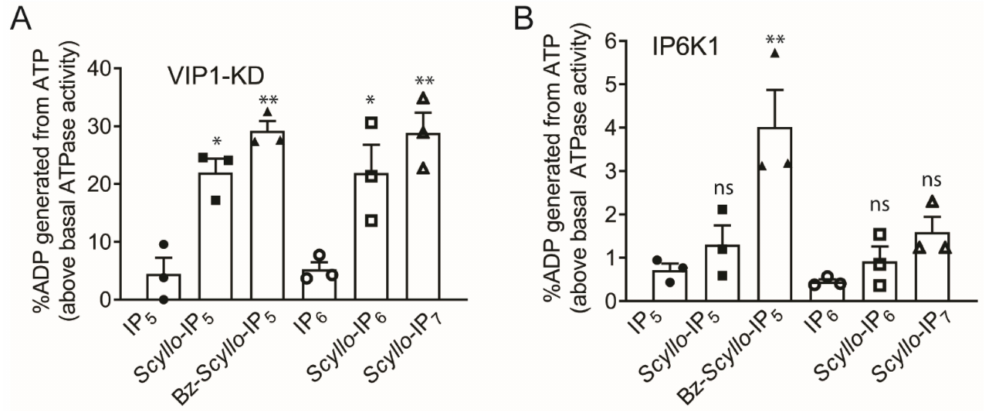
Figure 6. Percentage of ADP generated in the kinase reactions for ( A ) VIP1-KD and ( B ) IP6K1, after subtraction of basal ADP generated in the absence of substrate, for the data shown in Figure 5. The graphs show individual data points and mean ± SEM from three independent experiments. Data was analyzed using one-way ANOVA to compare ATPase activity in the presence of each scyllo -IPn with ATPase activity in the presence of either myo -IP 5 or myo -IP 6 (which were not significantly different from each other). ** p ≤ 0.01; * p ≤ 0.05; ns, not significant, p >